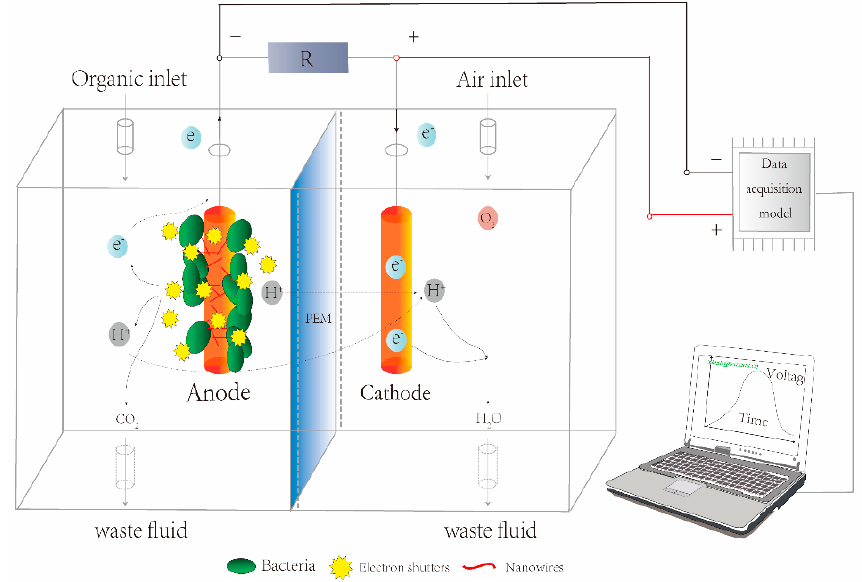
Figure 1. Diagram of a dual chamber microbial fuel cell (MFC).